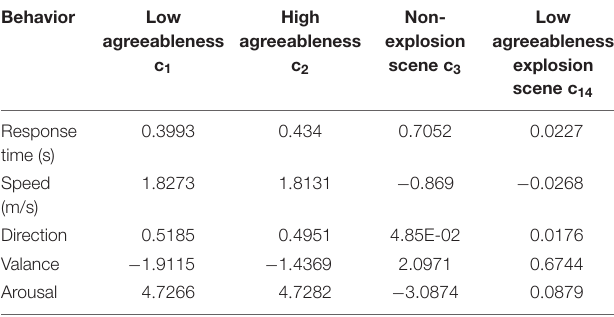
TABLE 11 | Interaction of agreeableness and experimental scene on individual emotional impact and escape